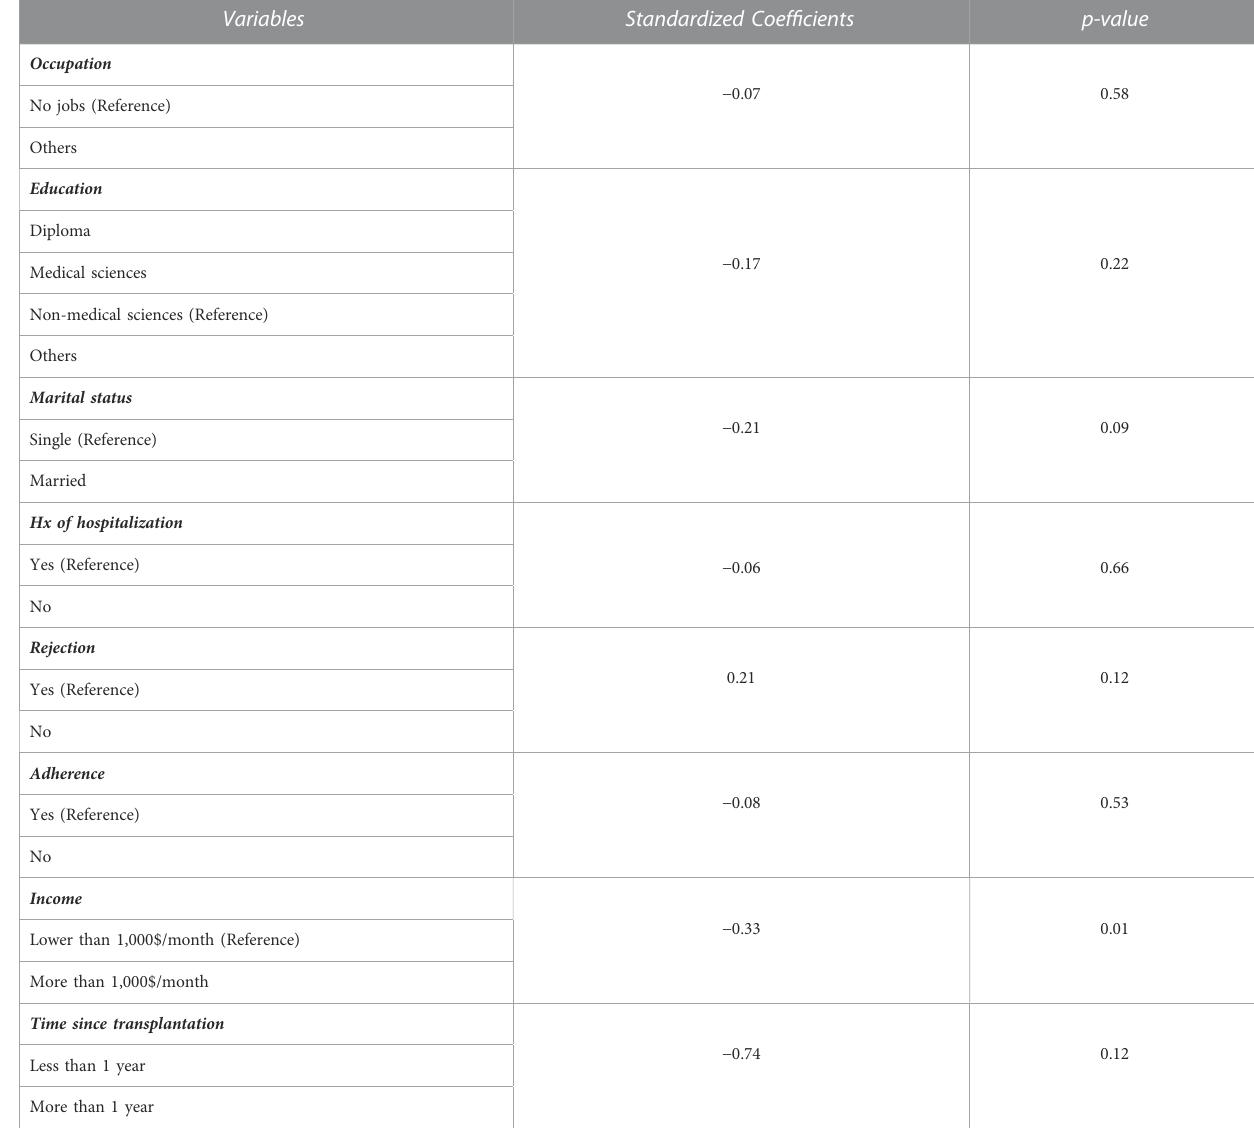
TABLE 4 Different demographic, socio-economic, cultural, and clinical factors concerning the quality of life among liver transplant